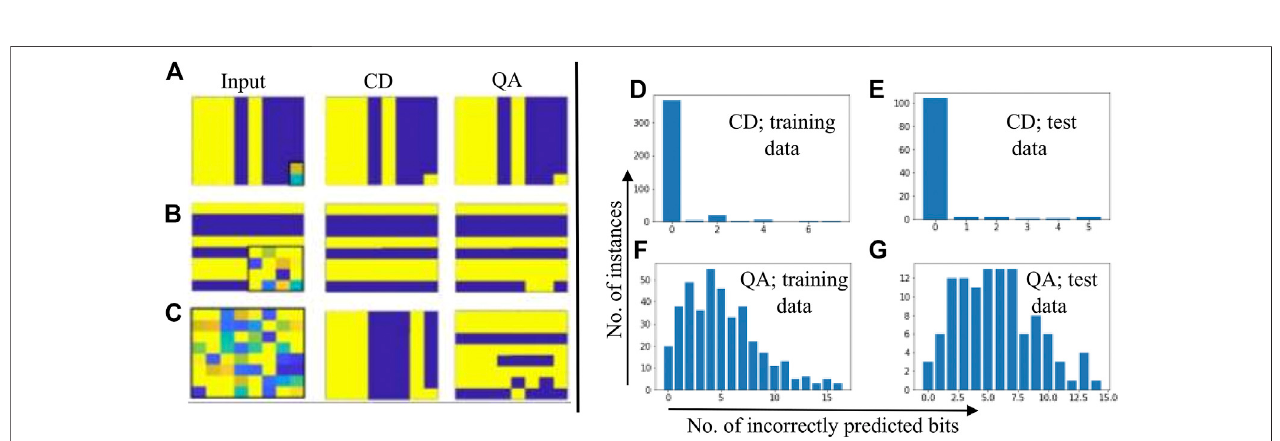
FIGURE 6 | Original data was fi rst corrupted, then reconstructed. Left panel: The images in the left column are input data fed to the RBMs; output obtained from theCDand QA-trainedRBMs isshown inthemiddleandright column, respectively. Thebitsoftheinputimagesthatwerecorrupted areenclosedinblackboxes. Right panel: Histograms showing the distribution of incorrectly predicted bits versus the number of instances; 16 bits of the records were corrupted and then reconstructed using trained RBMs.